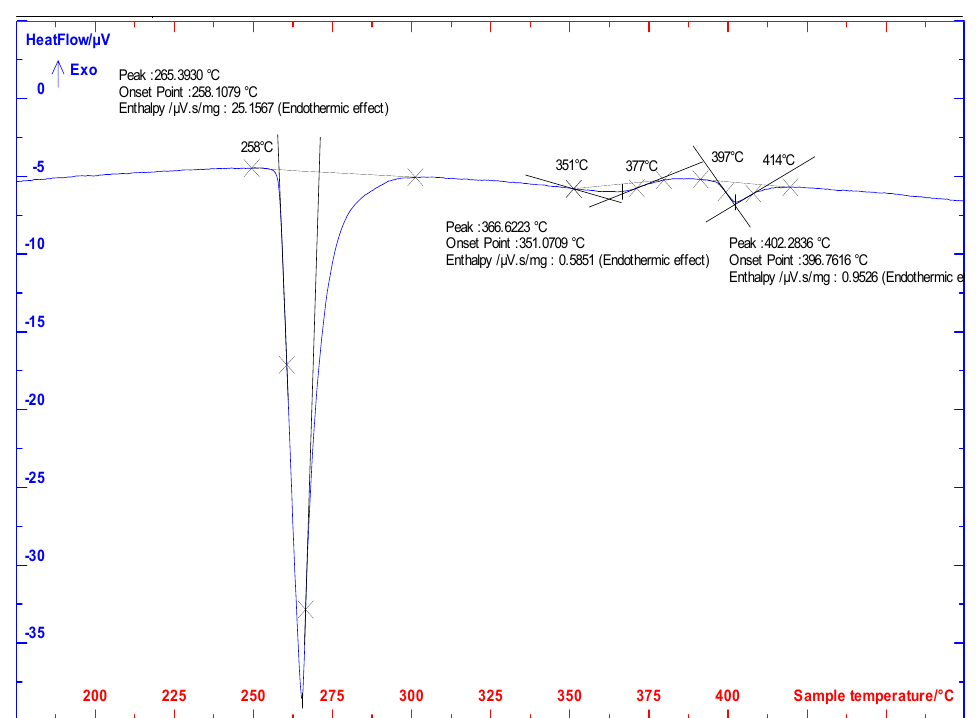
Figure 5. TG/DTA analysis of Bi11Ag1.5Ti solder, heating rate of 5 °C/min, second heating. Table 3. Significant temperatures of phase transformations determined by TG/DTA analysis.